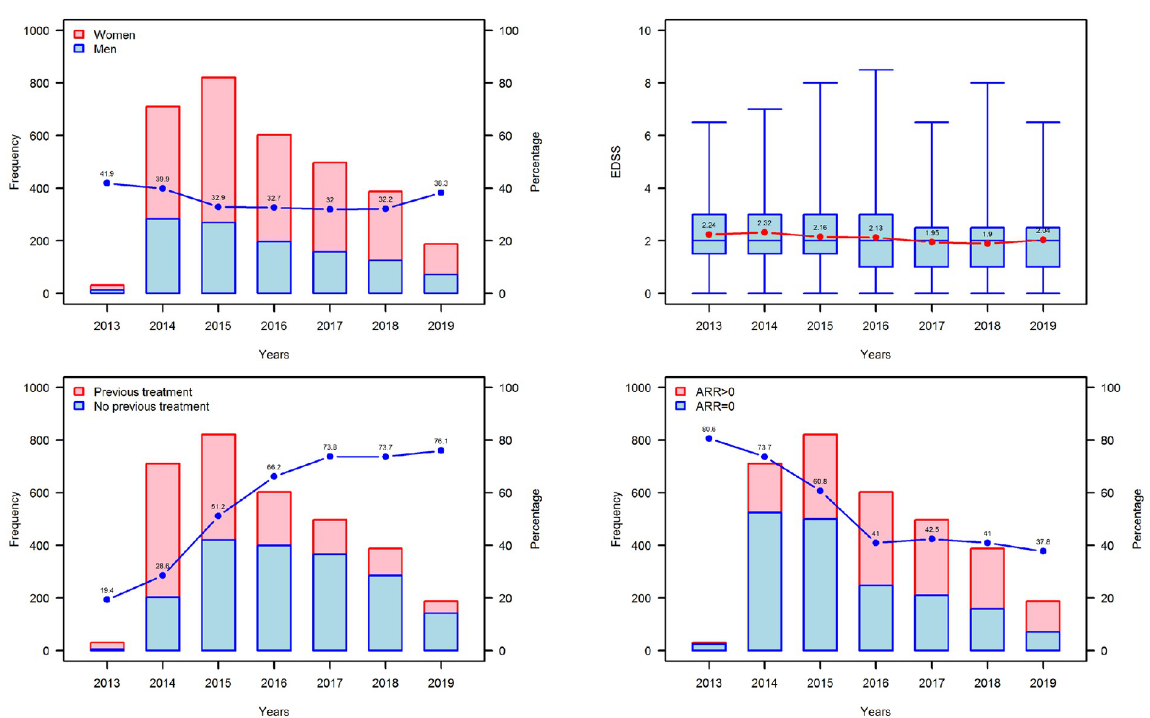
Fig 1. Baseline characteristics of patients starting teriflunomide treatment between 2013–2019 in Denmark. (A) Frequency and distribution of female (red) and male (blue) patients starting teriflunomide each year. The blue dots denote the percentage of male patients of the total teriflunomide patient starts each year (B) EDSS at teriflunomide start. The red dots show the mean EDSS, whereas the blue boxes show the median (IQR) EDSS per year. (C) Frequency and distribution of treatment-na ï ve (blue) and previously treated (red) patients starting teriflunomide each year. The blue dots denote the percentage of treatment-na ï ve patients of the total teriflunomide patient starts each year. (D) Frequency and distribution of patients with an annualized relapse rate (ARR) of 0 (blue) and ARR > 0 (red) in the year prior to teriflunomide start. The blue dots denote the percentage of patients with an ARR of 0 out of the total teriflunomide patient starts each year. Note, that teriflunomide received marketing authorization in October 2013 and the cut-off for data collection was September 2019, therefore patient numbers in 2013 and 2019 (dotted boxes) are based on data from approximately 3 and 9 months,